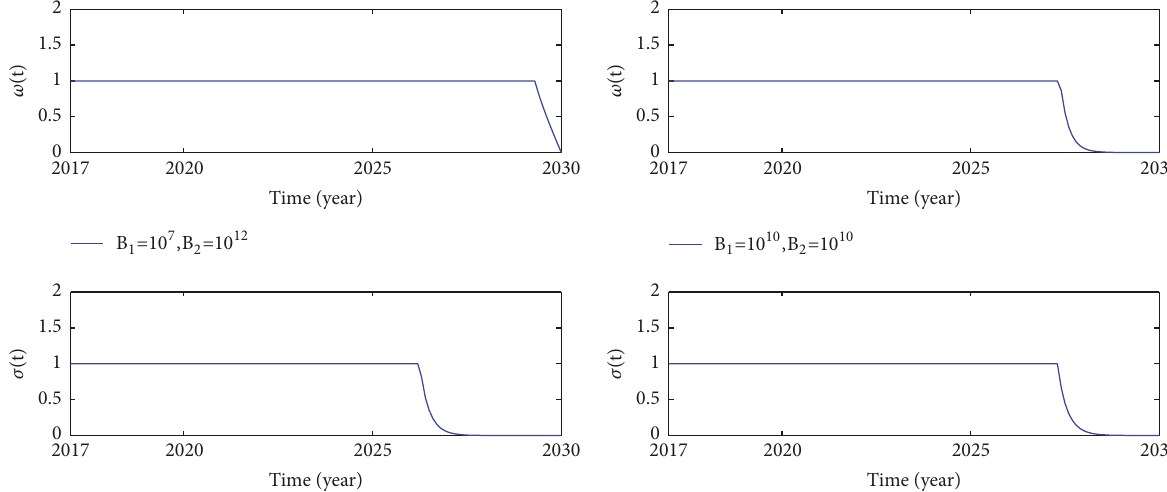
lower when the optimal control is used than that when current measures are used. Notice that the population of 𝑆 , 𝐼 , and 𝑇 increases slightly at the end of the time interval when the level of control implementation decreases, but it is still much less overall than that when current interventions is used. These comparisons begin from the initial year 2017, and the predictions of the subsequent years till 2030 are simulated with the same parameters as those in model application in Section 4, where the weight coefficients 𝐵 1 = 10 7 , 𝐵 2 = 10 12